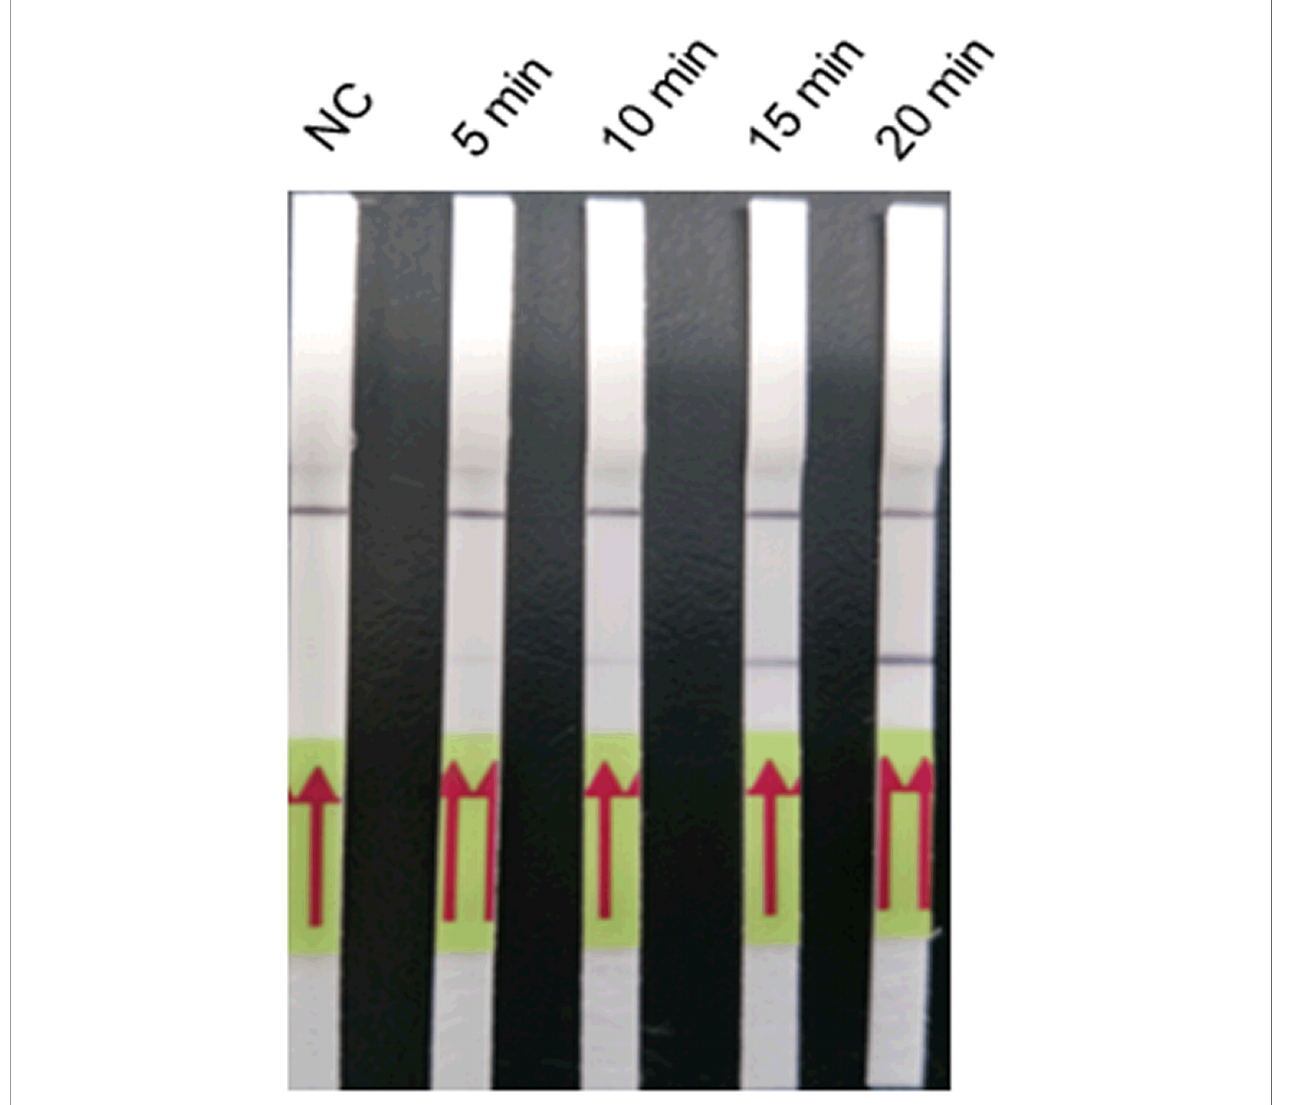
FIGURE 3 | Optimisation of the ampli fi cation duration of the LFD-PCR assay. The LFD-RPA assay results are positive for 5, 10, 15, and 20 min. The samples of 5, 10, 15, and 20 min were all 2.6 fg/ m l positive plasmid. Negative control (NC), DNA extracted from negative samples and ampli fi cation duration for 20 min. The red arrows stand for the direction of reaction solution diffusing in the lateral fl ow